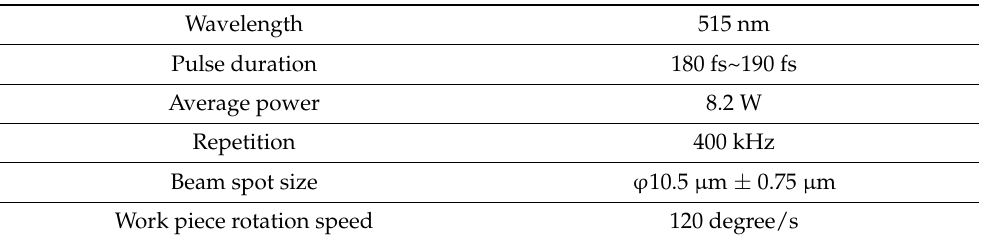
Table 1. Features of femtosecond laser trimming